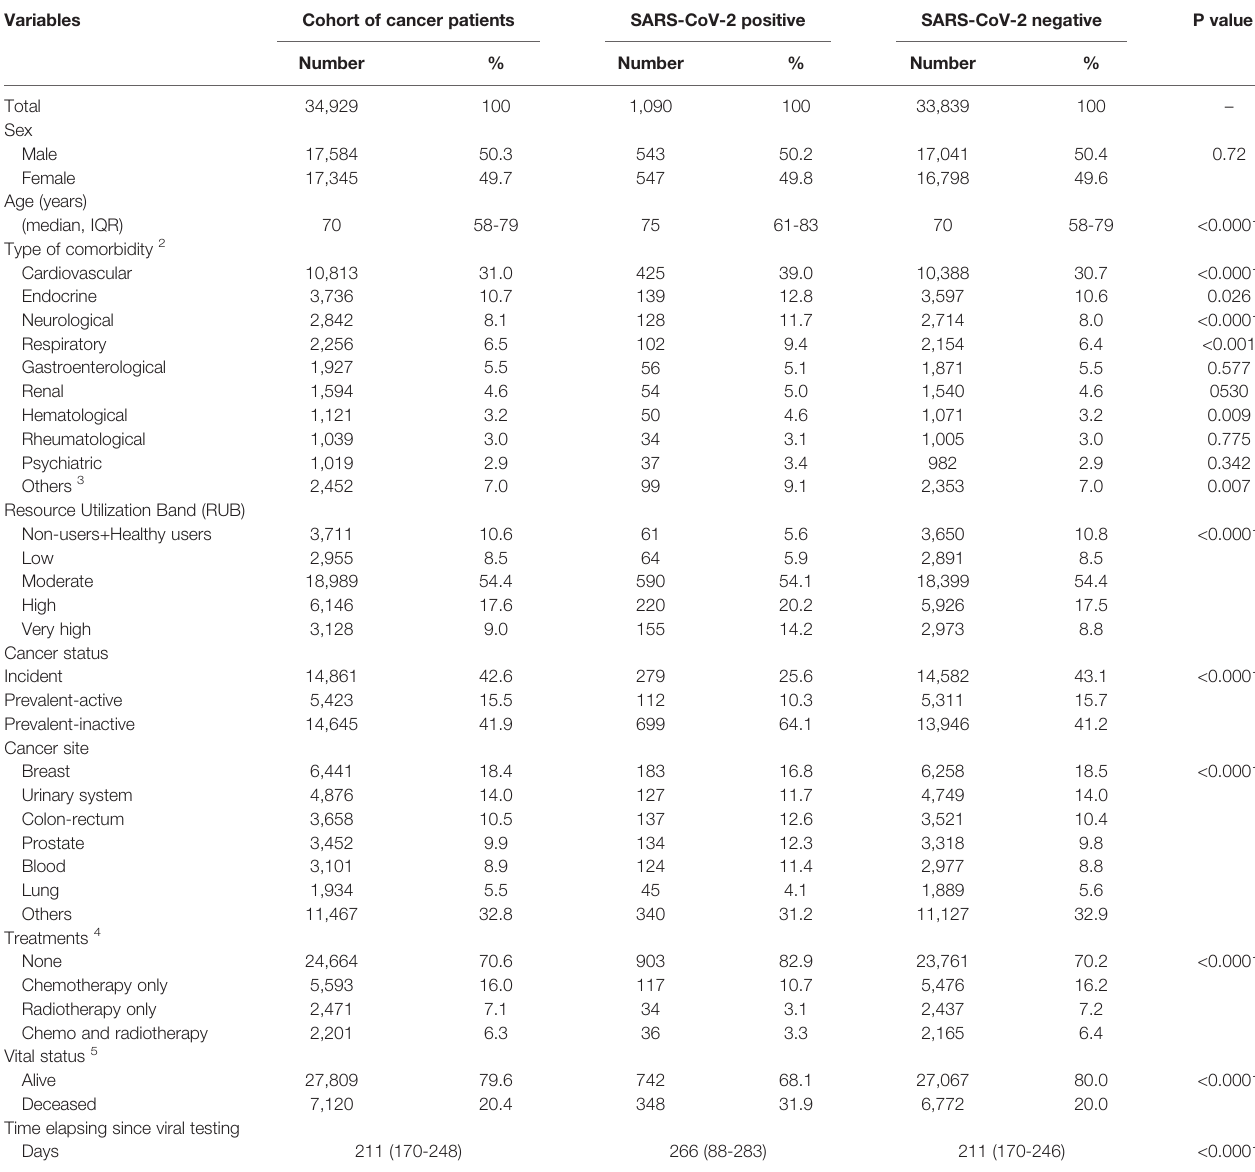
TABLE 1 | Demographics and clinical pro fi le of the study